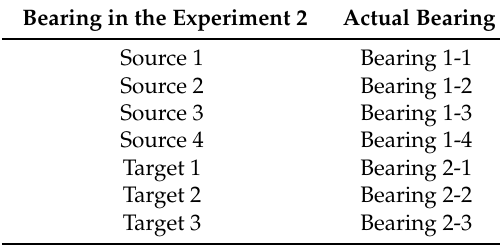
Table 2. Setting of experiment 2.